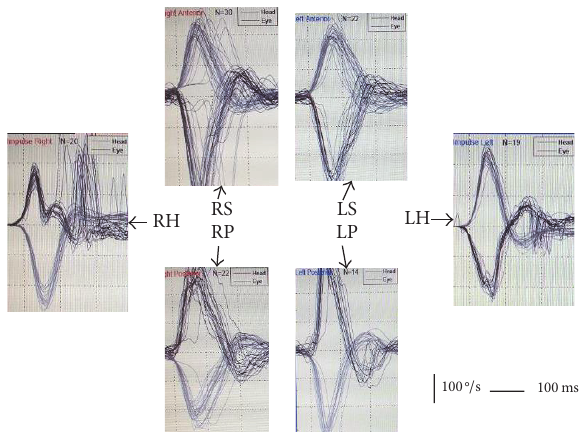
Figure 4: Case 3 . Video head impulse test of the 6 semicircular canals. R (right) and left (L) ears, superior (S), horizontal (H), and posterior(P)canals.Inthecaseoftheaffectedcanal(RH)thenormal eye response is substituted by covert refixation